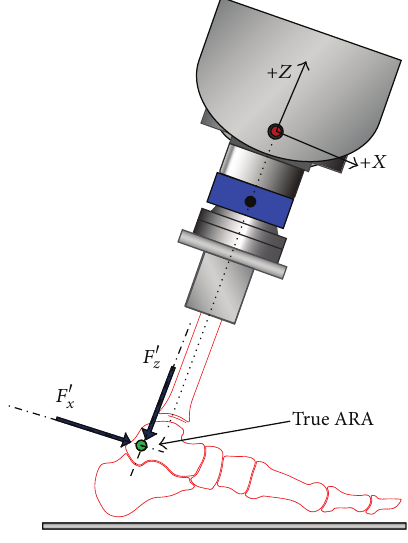
Figure 6: Kinematic and load control strategy for full load appli- cation simulation. Once the balanced position for pure moment loading was achieved (establishing the true ARA) the additional shear and compressive loads ( 𝐹 󸀠 𝑥 ,𝐹 󸀠 𝑧 ) were introduced to maintain the axial tibial force and vGRFs. By passing these forces through the rotational axis of the ankle, the moment value was unchanged. The NTT data remained aligned with the rotated tibia axes. Achilles load is not shown.